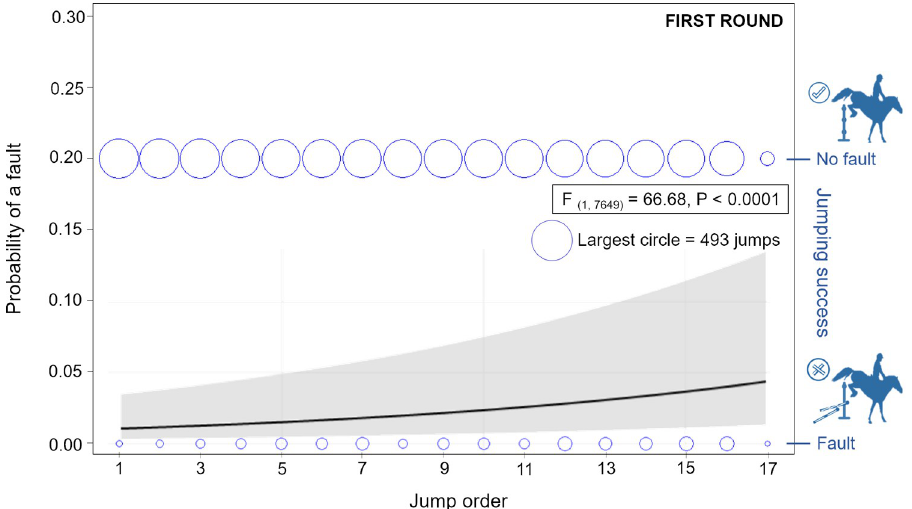
Fig 1. Predicted probability of a fault according to the jump order within the course of the first round. Predicted probability of a fault according to the jump order within the course of the first round (GzLMM, PROC GLIMMIX, SAS). The line and grey field show the predicted probability of a fault ± 95% confidence limit. Two rows of circles represent raw data of numbers of faults (bottom row) or successful jumps (upper row) on the fences. Circle size reflects the number of observations on a particular